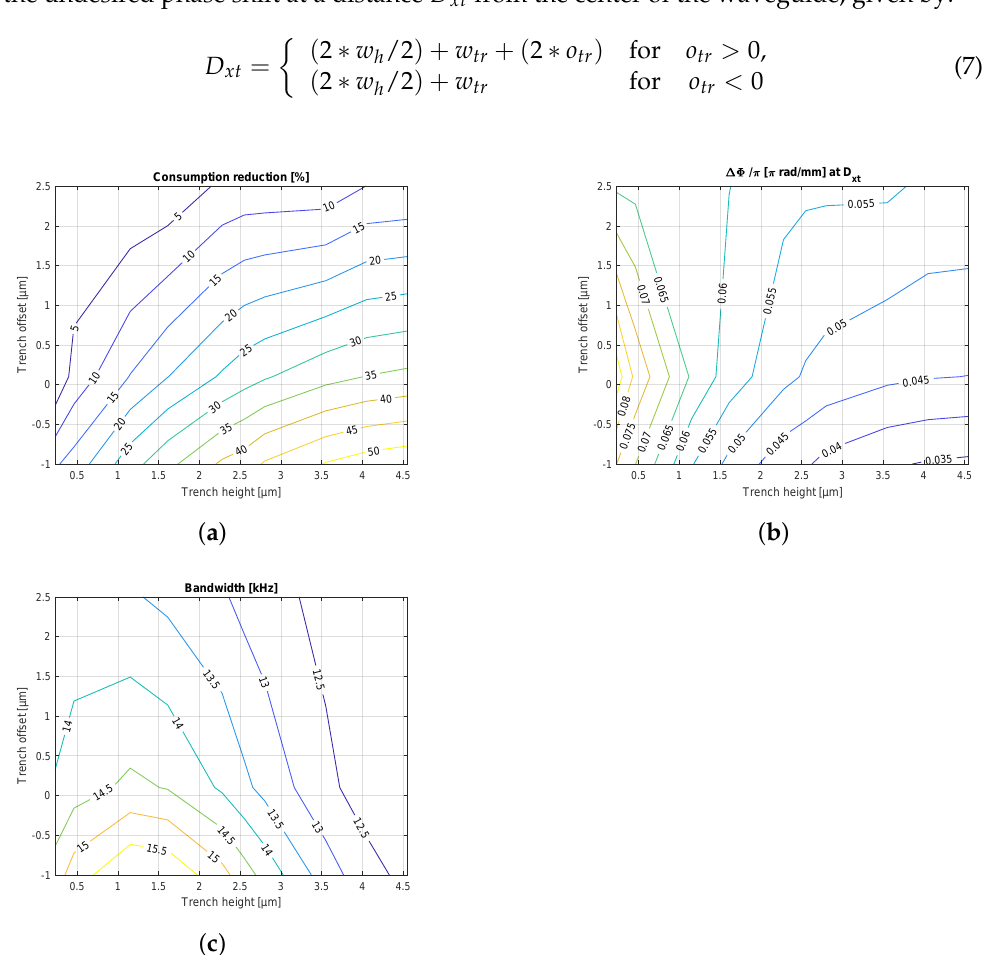
Figure 3. Performance contour plots varying the trench height ( h tr ) and offset ( o tr ) at π phase shift for a heater and trench width ( w tr ) of 7 µ m: consumption reduction ( a ), crosstalk phase shift ( b ), and bandwidth ( c